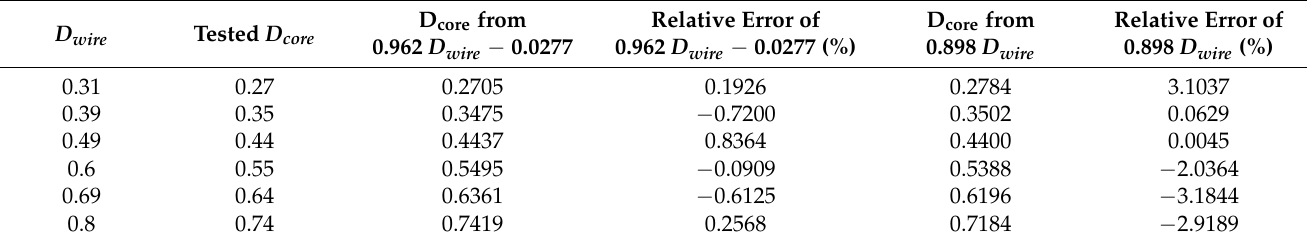
Figure 3. Actual and fitted values of D core simultaneously supplied the relative errors of the fitting lines with and without an intercept. Table 3. Linear fitting between D core and D wire when D wire ∈ [0.3, 0.8].